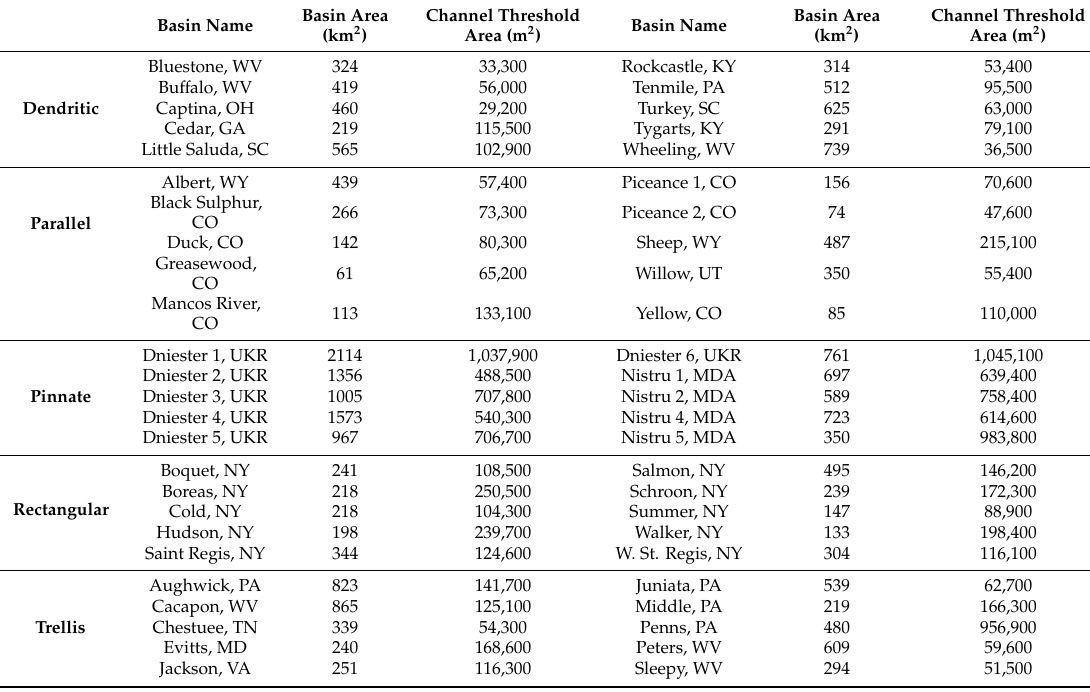
Table 1. Basin areas and channel threshold areas for the 50 analyzed basins. The thresholds are identified between the colluvial and bedrock channel segments in the slope-area